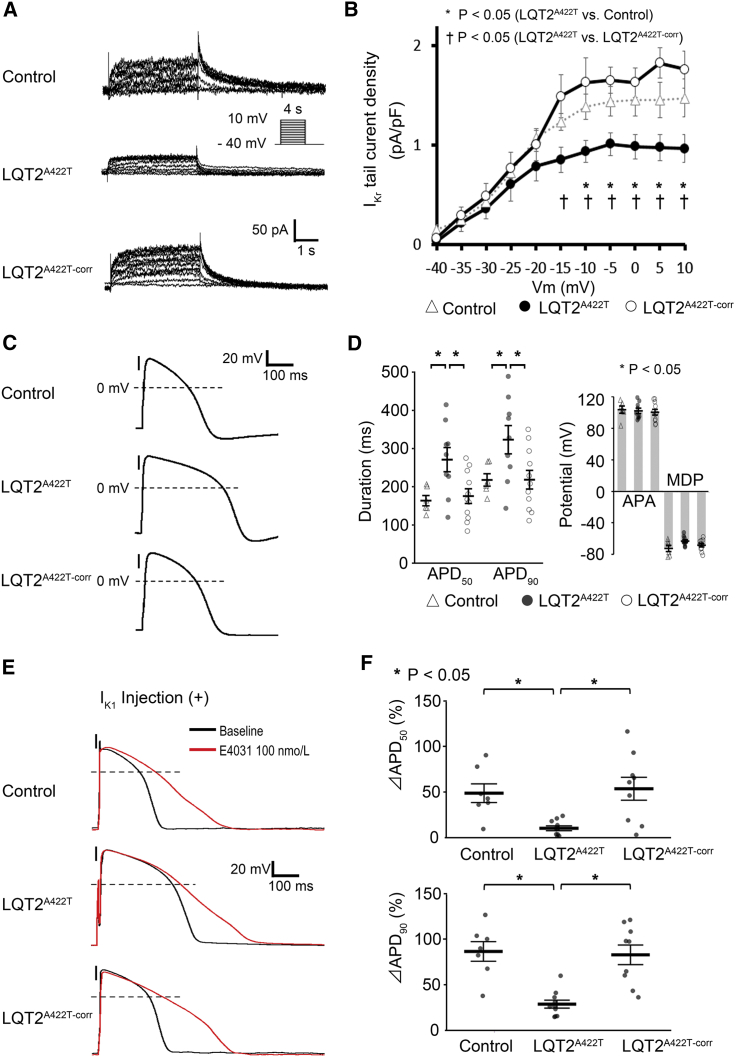
Electrophysiological Properties of iPSC-CMs and AP Response to IKr Blockade(A) Representative current traces of the IKr in Control-, LQT2A422T-, and LQT2A422T-corr-iPSC-CMs.(B) Average current-voltage relationships for peak tail currents in Control-, LQT2A422T-, and LQT2A422T-corr-iPSC-CMs (independent experiments, n = 8, 6, and 5 from independent differentiation experiments, n = 4, 4, and 3, respectively; mean ± SEM; p = 0.029; two-way repeated measures ANOVA). ∗p < 0.05, Fisher's LSD post hoc test for Control versus LQT2A422T; †p < 0.05, LQT2A422T-corr versus LQT2A422T.(C) Representative traces of AP with 1-Hz pacing.(D) APD50 and APD90 in Control-, LQT2A422T-, and LQT2A422T-corr-iPSC-CMs (independent experiments, n = 6, 9, and 11, from independent differentiation experiments, n = 5, 6, and 5, respectively; mean ± SEM; p = 0.010 and p = 0.025 for APD50 and APD90, respectively; one-way ANOVA). ∗p < 0.05, Fisher's LSD post hoc test for APD50 and APD90.(E) Representative AP traces changed by IKr blockade.(F) Percentage of APD prolongation after E4031 treatment (%ΔAPD) at 1-Hz pacing in each cell line. %ΔAPD50 and %ΔAPD90 in Control-iPSC-CMs and LQT2A422T-corr-iPSC-CMs versus LQT2A422T-iPSC-CMs (independent experiments, n = 7, 10, and 10 from independent differentiation experiments, n = 5, 5, and 6 in Control-, LQT2A422T-, and LQT2A422T-corr-iPSC-CMs, respectively; mean ± SEM; p = 0.001; two-way repeated measures ANOVA). ∗p < 0.05, Fisher's LSD post hoc test.See also Figure S2.APA, action potential amplitude; MDP, maximum diastolic potential.